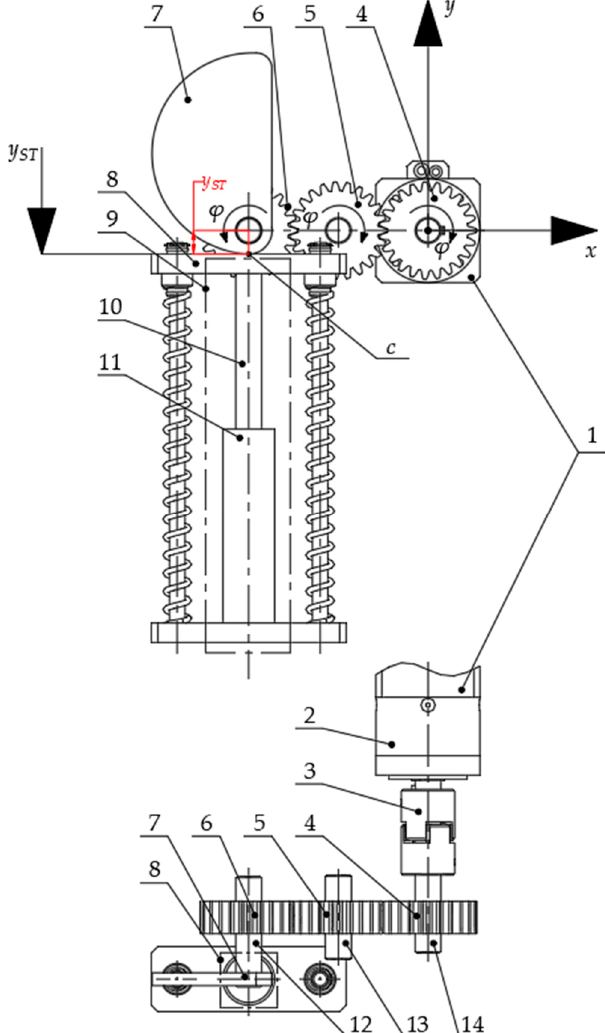
Figure 13. Kinematic diagram of the drive system for the stamp–sleeve compacting assembly, where: 1—electrical motor; 2—reduction gearbox; 3—coupling; 4—gear wheel 1; 5—gear wheel 2; 6—gear wheel 3; 7—cam; 8—upper plate moving along the guides; 9—stamp–sleeve compacting unit with guides and pressure springs; 10—stamp; 11—sleeve; 12, 13 and 14—shafts for mounting gear wheels 1, 2 and 3; i 1 —gear ratio of the gearbox directly connected to the motor; i 2 = i 3 = 1—the gear ratios of paired gear wheels; y ST —stamp displacement and φ —cam rotation angle.